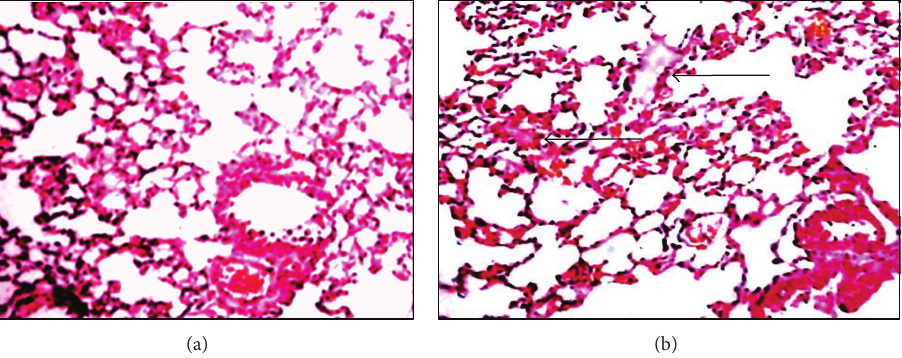
Figure 8: Lung histological analysis of mice exposed to diphenyl ditelluride 50 𝜇 mol/kg. (a) Lung section of control group showing bronchioles, blood vessels, and adjacent alveoli with normal morphology. (b) Lung section of diphenyl ditelluride treated mice showing the presence of some isolated areas with intra-alveolar edema (arrows) (H&E 10x). The picture represents the sum of three independent